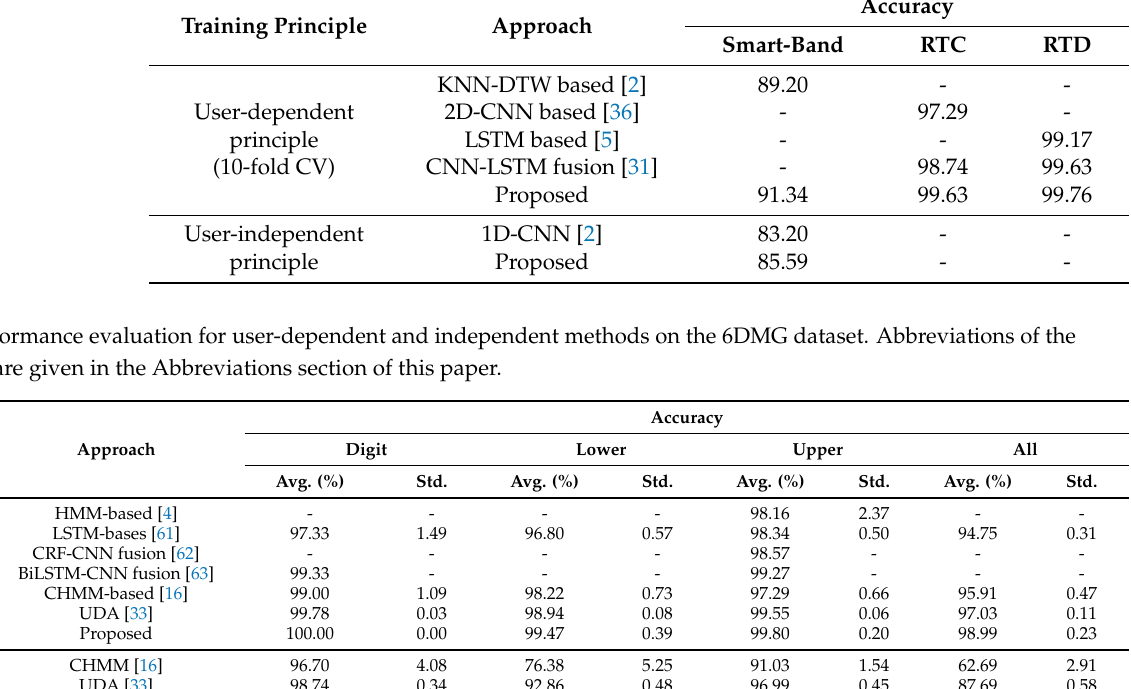
Table 6. Performance evaluation for user-dependent and independent method on smart-band and RealSense-based Trajectory datasets. Abbreviations of the approaches are given in the Abbreviations section of this paper.